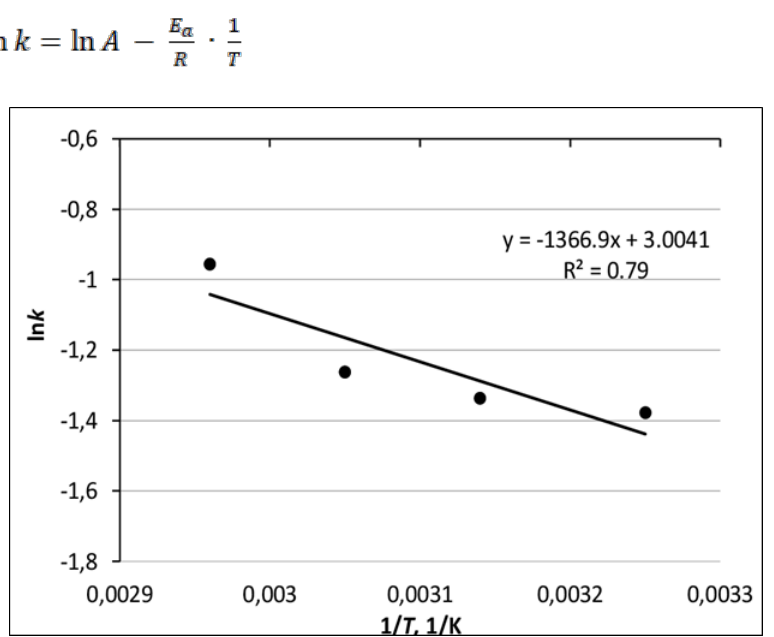
Figure 6. Linear plot of ln k versus 1/T resulting from H catalyzed esterification of propanoic acid with